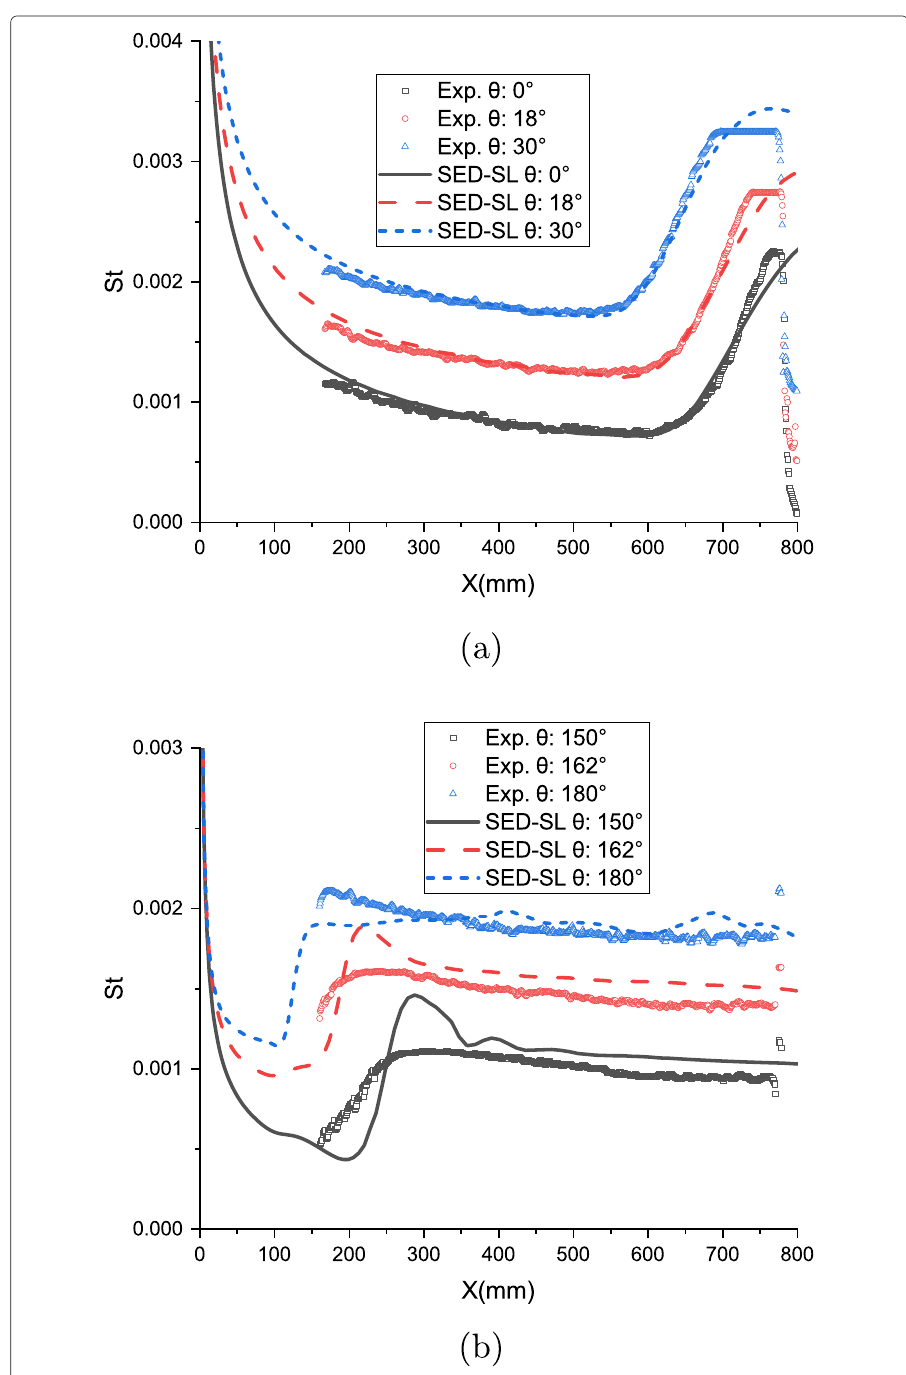
Fig. 11 Comparisons between the rescaled surface temperature increment distributions measured in experiment and the St distributions computed by the SED-SL model for the CARDC-4 case. a The windward surface, b the leeward surface. The data are vertically translated to be clearly displayed